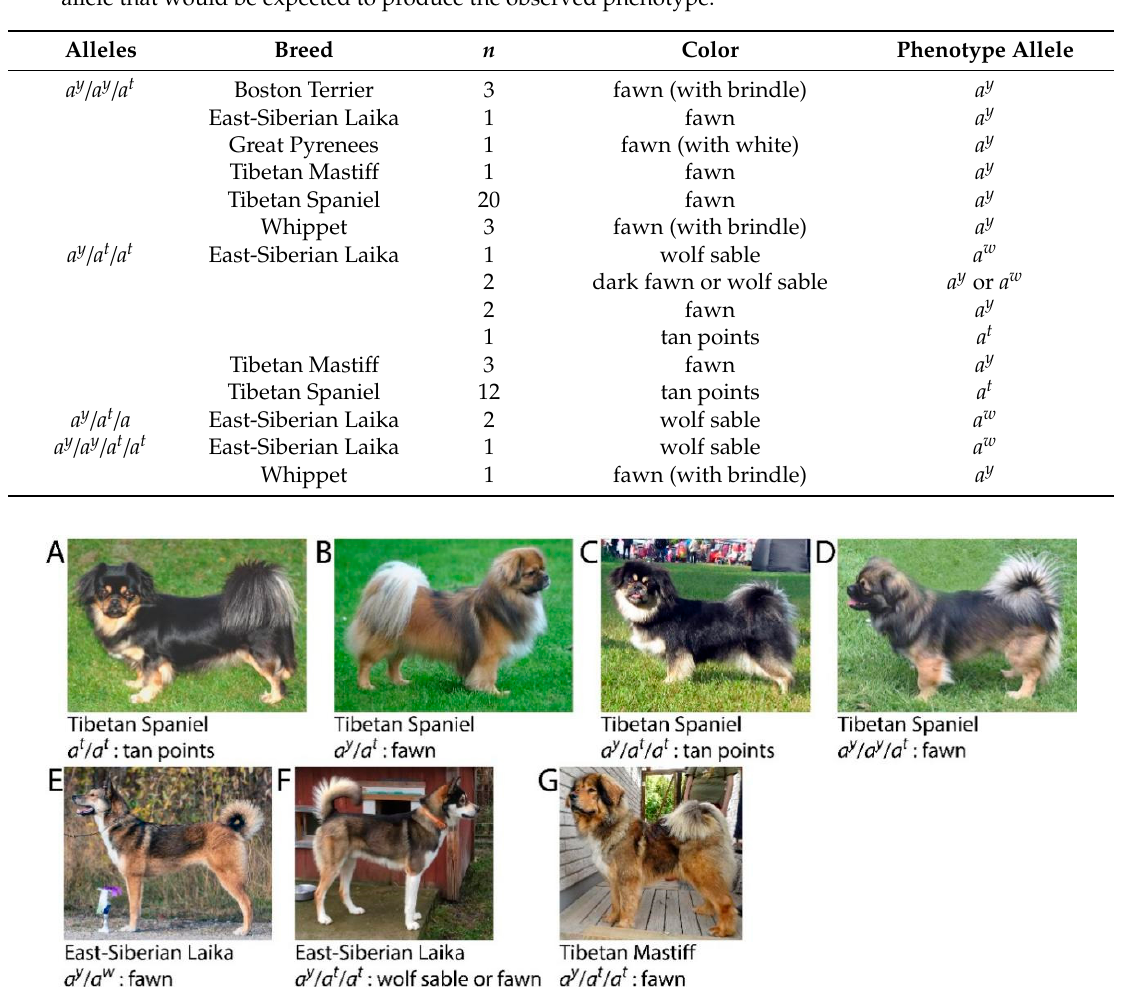
Table 3. Phenotypes expressed with each observed ASIP allele combination . Phenotypes are available for some dogs (total n = 54) of the WHAE and MLAS cohorts. The “phenotype allele” refers to the allele that would be expected to produce the observed phenotype.